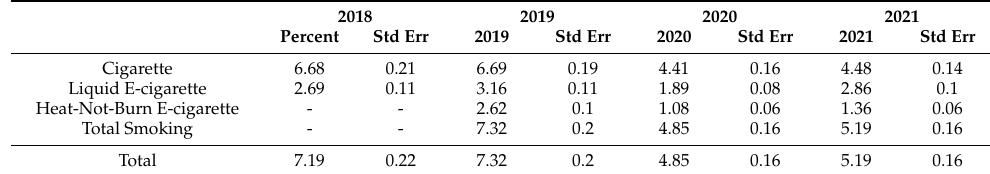
Table 2. Overall Results of Current Smoking Rates.